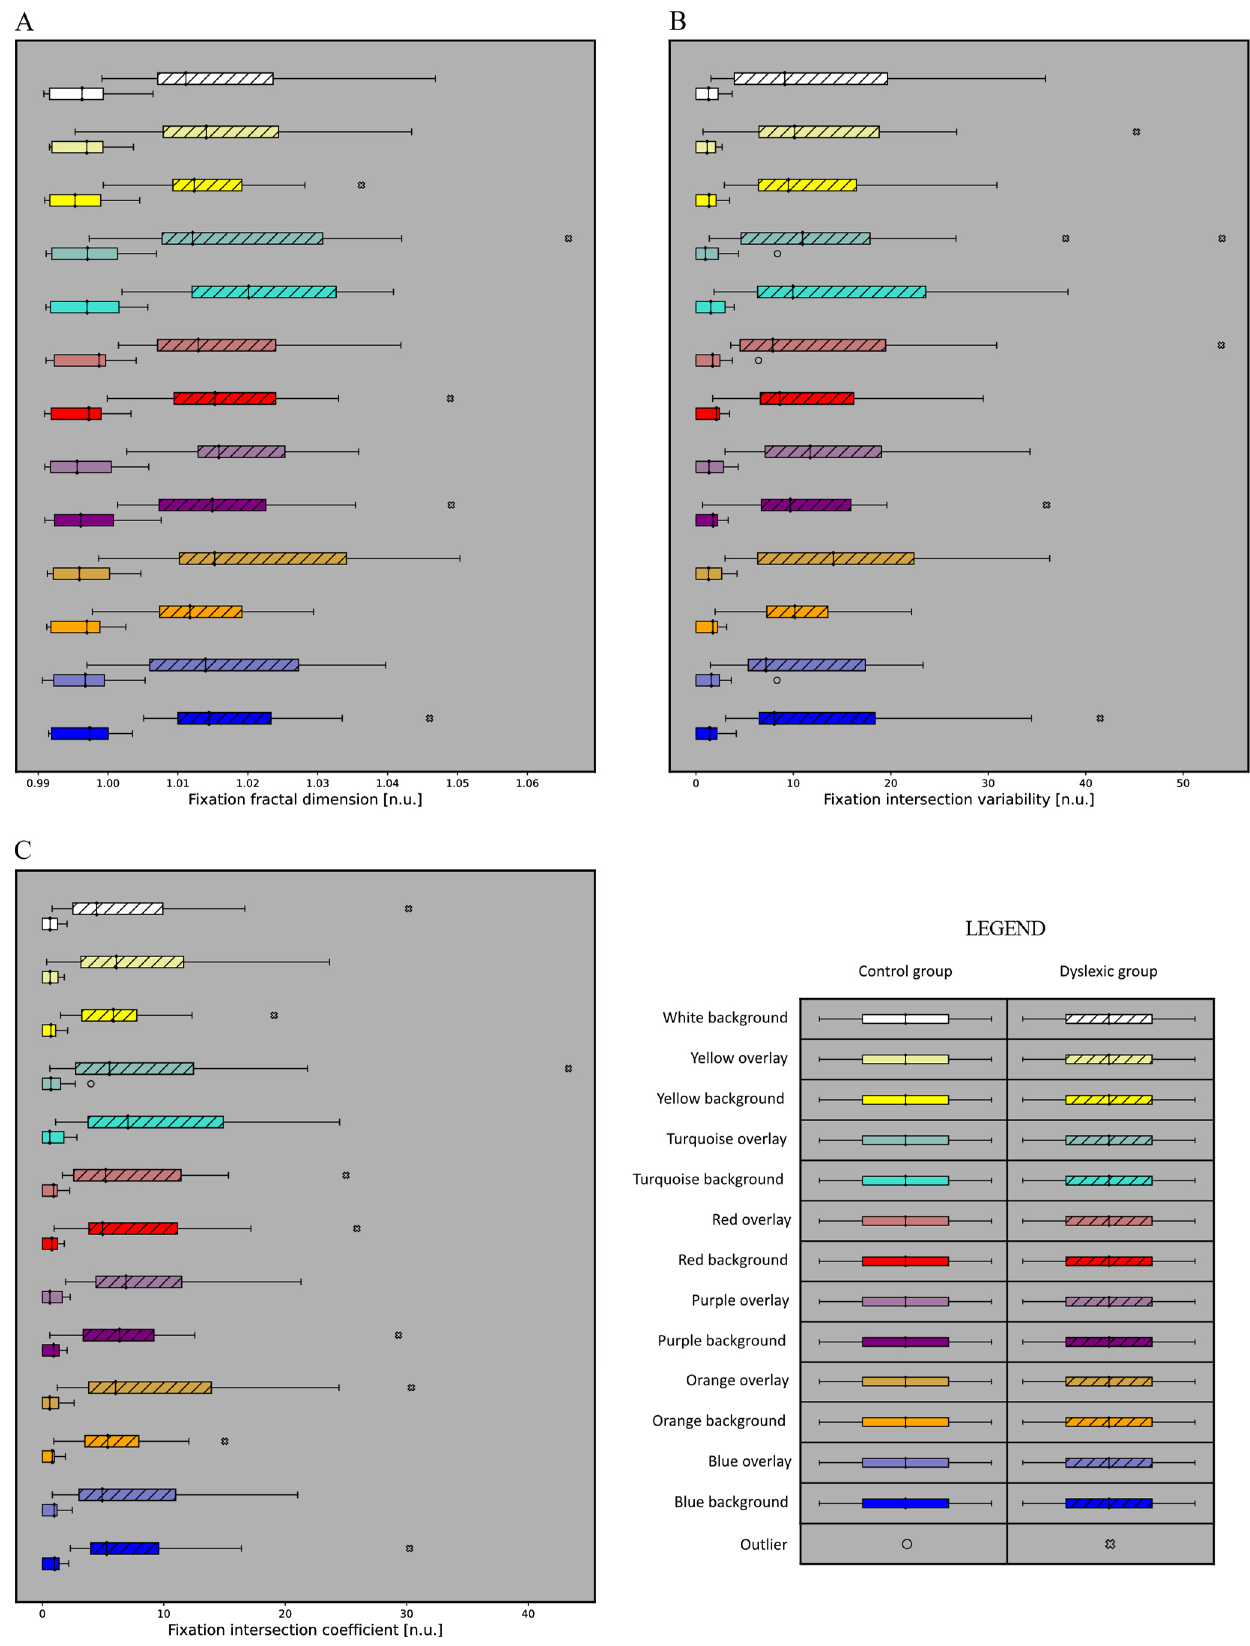
Figure 4. The boxplots of ( A ) Fixation intersection coefficient , ( B ) Fixation fractal dimension , ( C ) Fixation intersection variability for each color configuration and two subject groups (dyslexic and control).